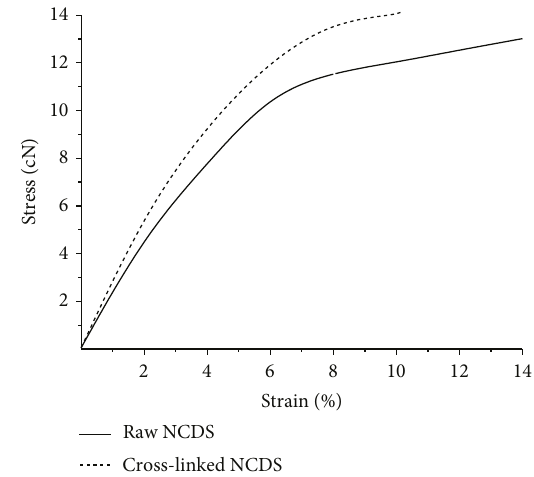
Figure 7: Typical stress and strain curve of NCS fi ber before and after cross-linking with phytic